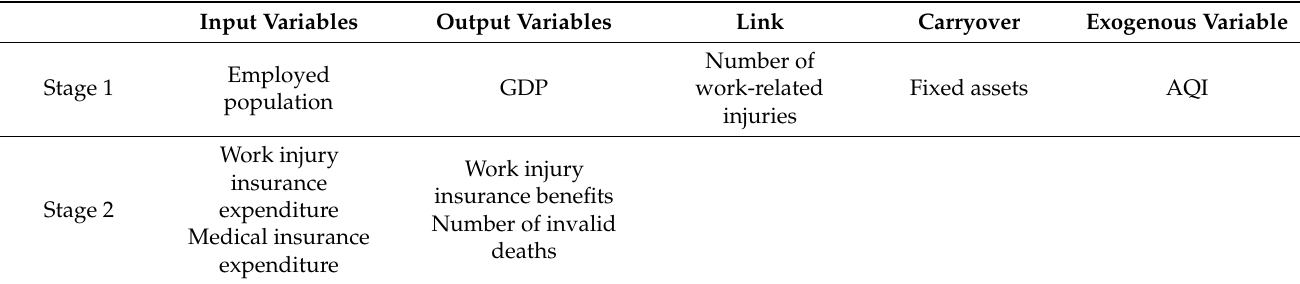
Table 1. Input and output